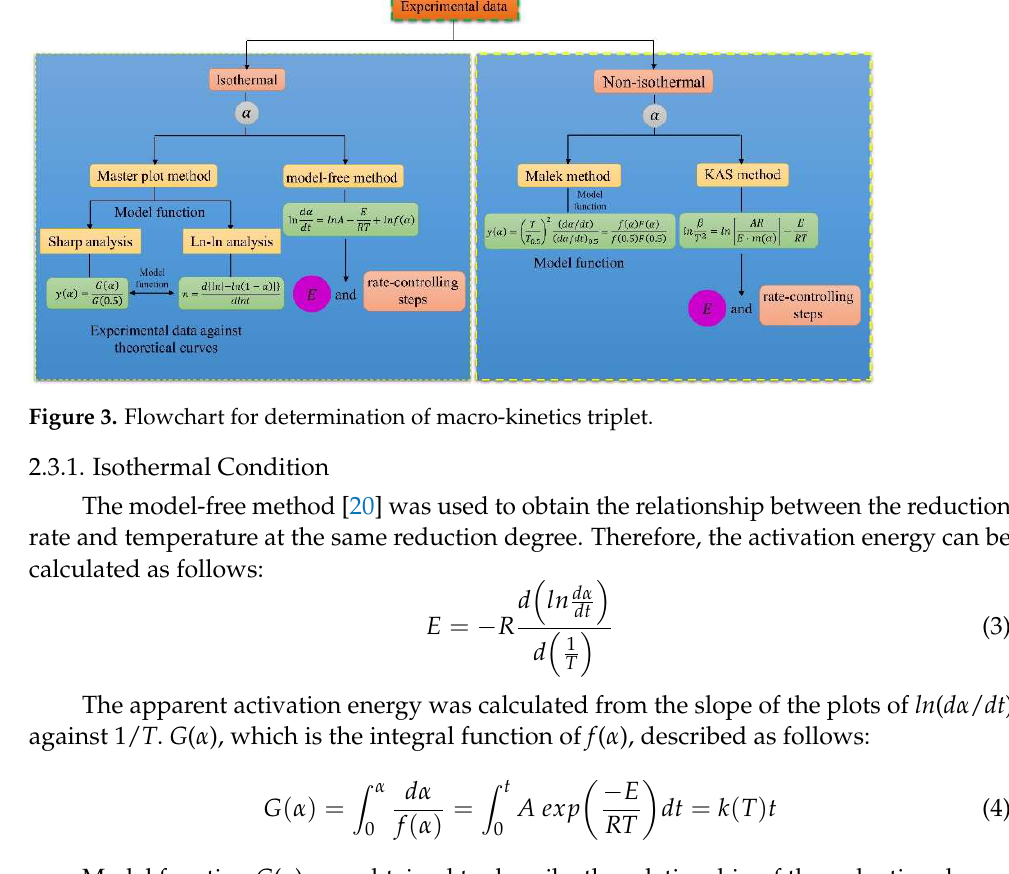
Table 2. Model function G ( α ) for normal solid-state